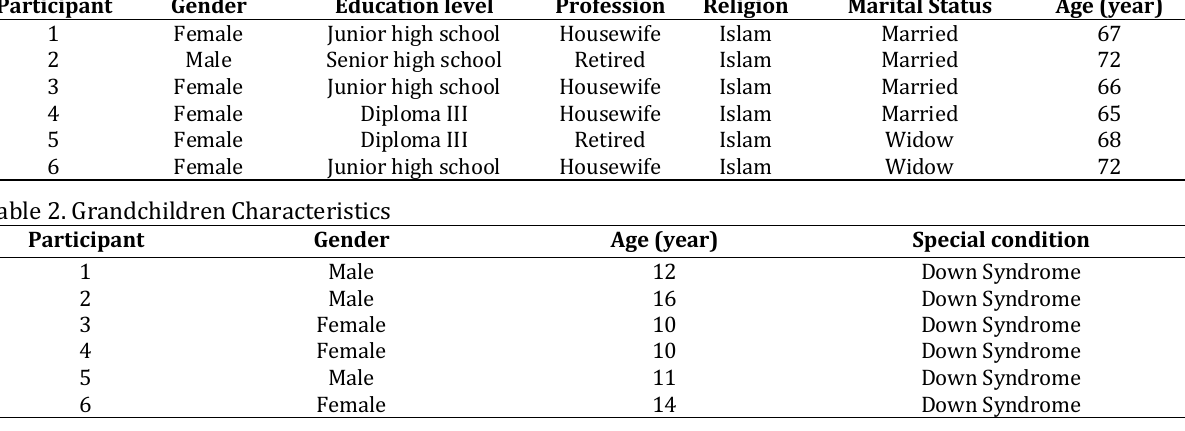
Table 1. Grandparent Characteristics